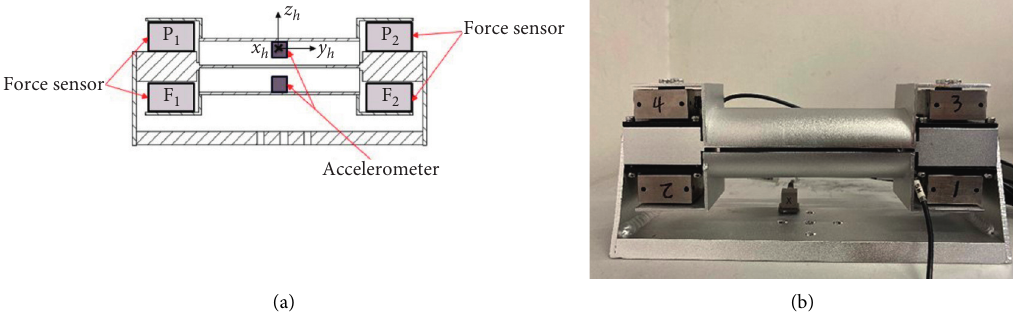
Figure 3: Vibration handle. (a) Structural sketch. (b) Physical